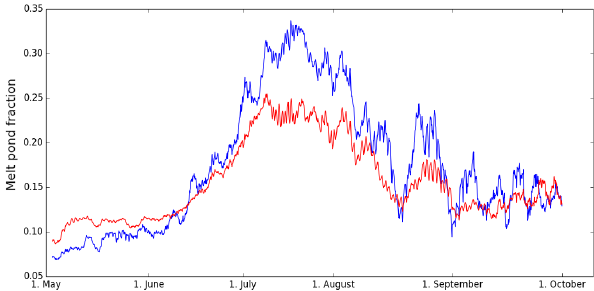
Figure 3. Swathwise comparison of the MERIS cloud mask used in the MPD retrieval to the AATSR cloud mask presented in Istomina et al. (2010). The region covered is the Arctic Ocean to the north of 65 ◦ N (land masked out). All available swaths from 1 May 2009 to 30 September 2009 have been taken. Blue curve: MPF retrieved with MPD averaged in cloud-free areas as seen by AATSR (refer- ence or “perfect” cloud mask). Red curve: MPF retrieved with MPD averaged in cloud-free areas as seen by MERIS (potentially cloud contaminated mask). The smoothing out effect of unscreened clouds is visible in the behaviour of the red